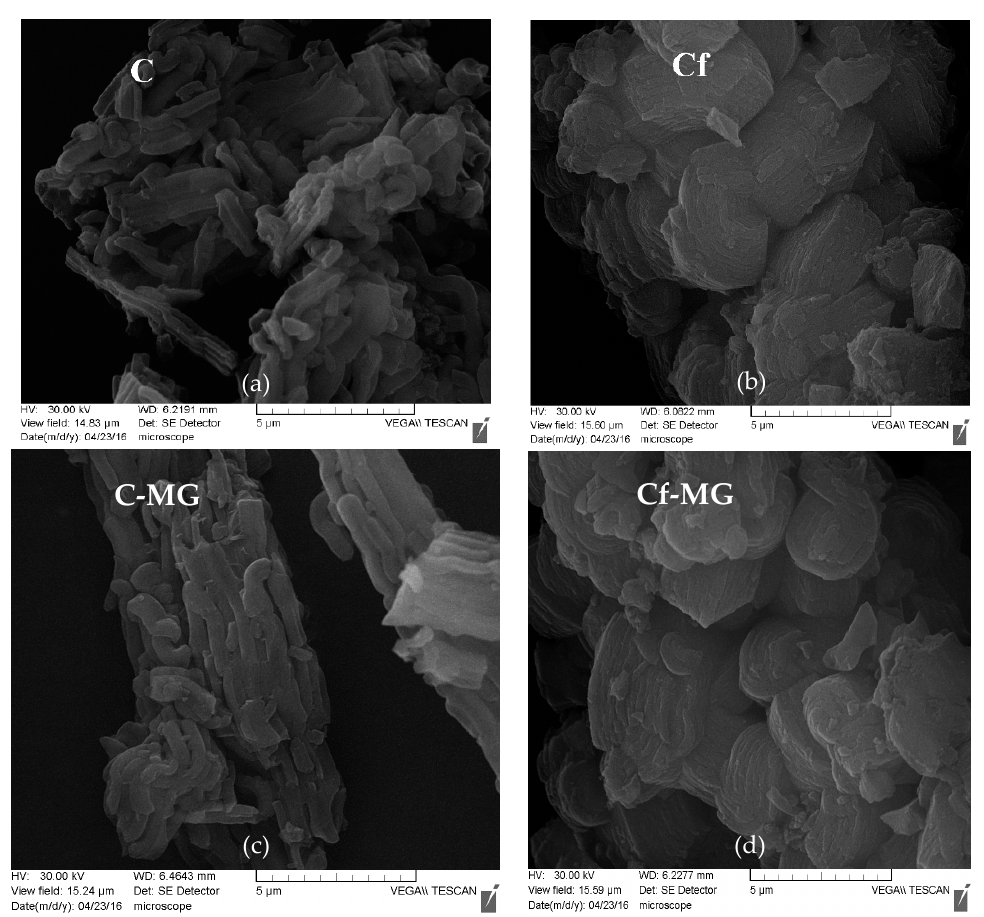
Figure 2. SEM images for: ( a ) pure SBA ‐ 15 silica (C); ( b ) functionalized SBA ‐ 15 silica with APTES (Cf); ( c ) magnolol loaded in SBA ‐ 15 silica (C ‐ MG) and ( d ) magnolol loaded in functionalized SBA ‐ 15 silica with APTES (Cf ‐ MG).